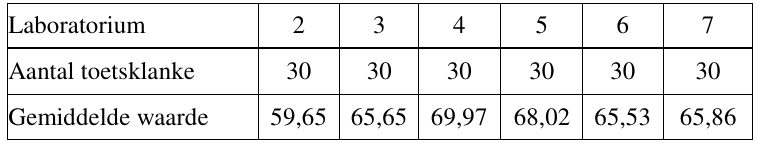
GEMIDDELDE GELYKE LUIDHEIDSWAARDES VAN TOETSKLANKE OP DIE 75 DB